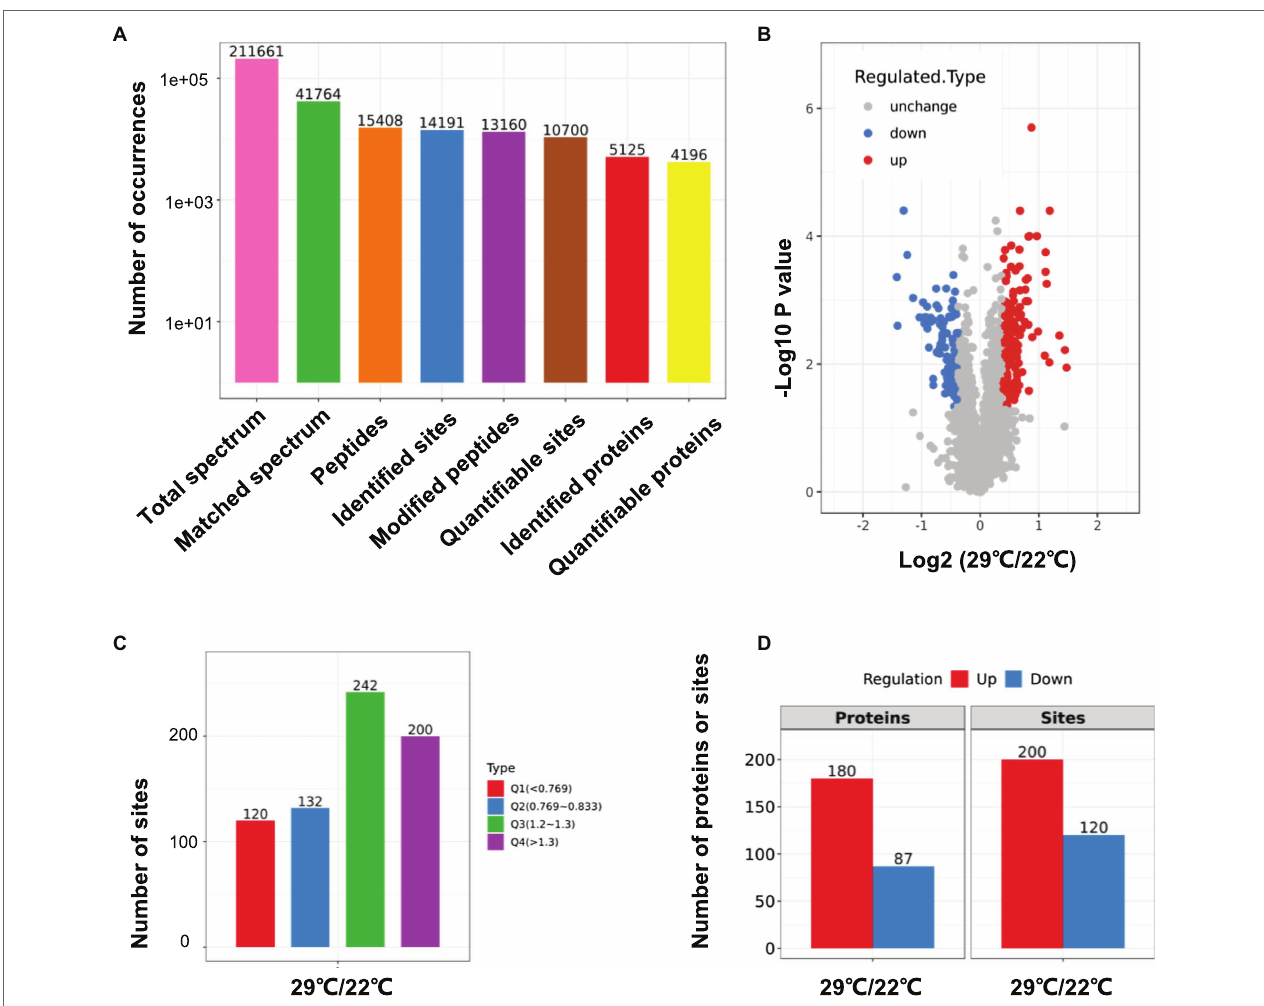
FIGURE 3 | Phosphoproteomic study on thermo-responsiveness in Arabidopsis . Two-day-old Arabidopsis wild-type plants were treated at 22 ° C or 29 ° C for 3 h, and etiolated tissues were sampled for TMT-based phosphoproteomic analysis. Basic information on proteomics was shown in (A–C) and the number of differentially phosphorylated proteins/sites (Q1 and Q4 in C) was shown in (D)